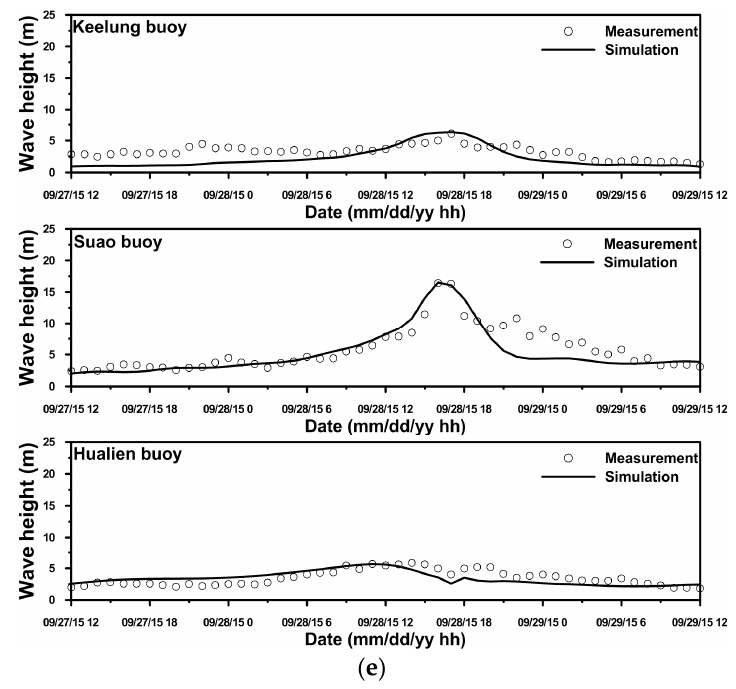
Figure 5. Comparisons of modeled and observed wave heights during: ( a ) Typhoon Saola in 2012; ( b ) Typhoon Soulik in 2013; ( c ) Typhoon Matmo in 2014; ( d ) Typhoon Soudelor in 2015; and ( e ) Typhoon Dujuan in 2015.